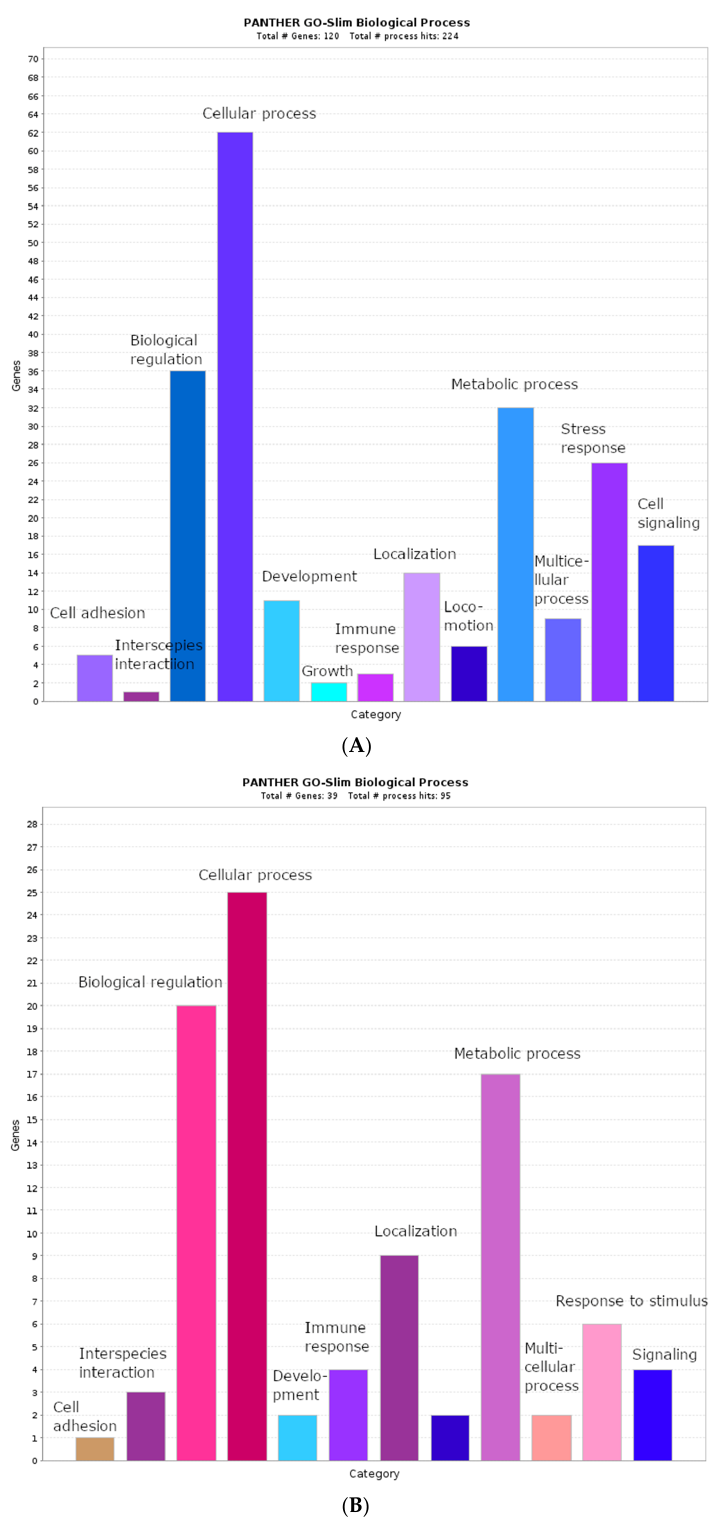
Figure 1. Representation of gene-ontology-based biological process enrichment categorization of genes encoding ( A ) AFP 14–20 -like motif-containing proteins and ( B ) GIP-9-like motif-containing proteins. The gene list enrichment analysis tool of PANTHER17.0 was applied. All query genes were retrieved from UniprotKB knowledgebase and then converted to ENSEMBL gene IDs.